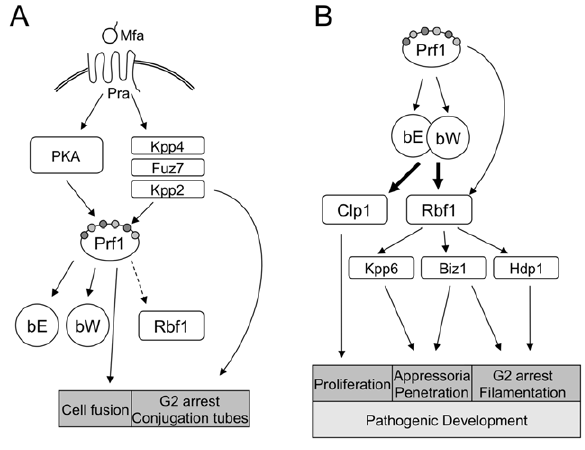
Figure 7. Key factors of a - and b -dependent development in U.maydis . ( A ) Activation of the pheromone pathway after pheromone (Mfa) binding to the cognate receptor (Pra) triggers a signalling casacde via PKA and MAPK phospho-relays. Differential phosphorylation of the HMG transcription factor Prf1, in turn, leads to expression of the b -mating type locus gene bE and bW. ( B ) After cell fusion, sexual and pathogenic development is orchestrated by the bE/bW-heterodimer, coordinating the key players of important developmental steps: Clp1 is required for in planta proliferation; Rbf1 is the central transcriptional regulator, controlling appressoria formation and penetration of the host plant via the transcription factor Biz1 and the MAPK Kpp6, as well as filamentous growth and the G2 cell cycle arrest by concerted action of Biz1 and Hdp1.